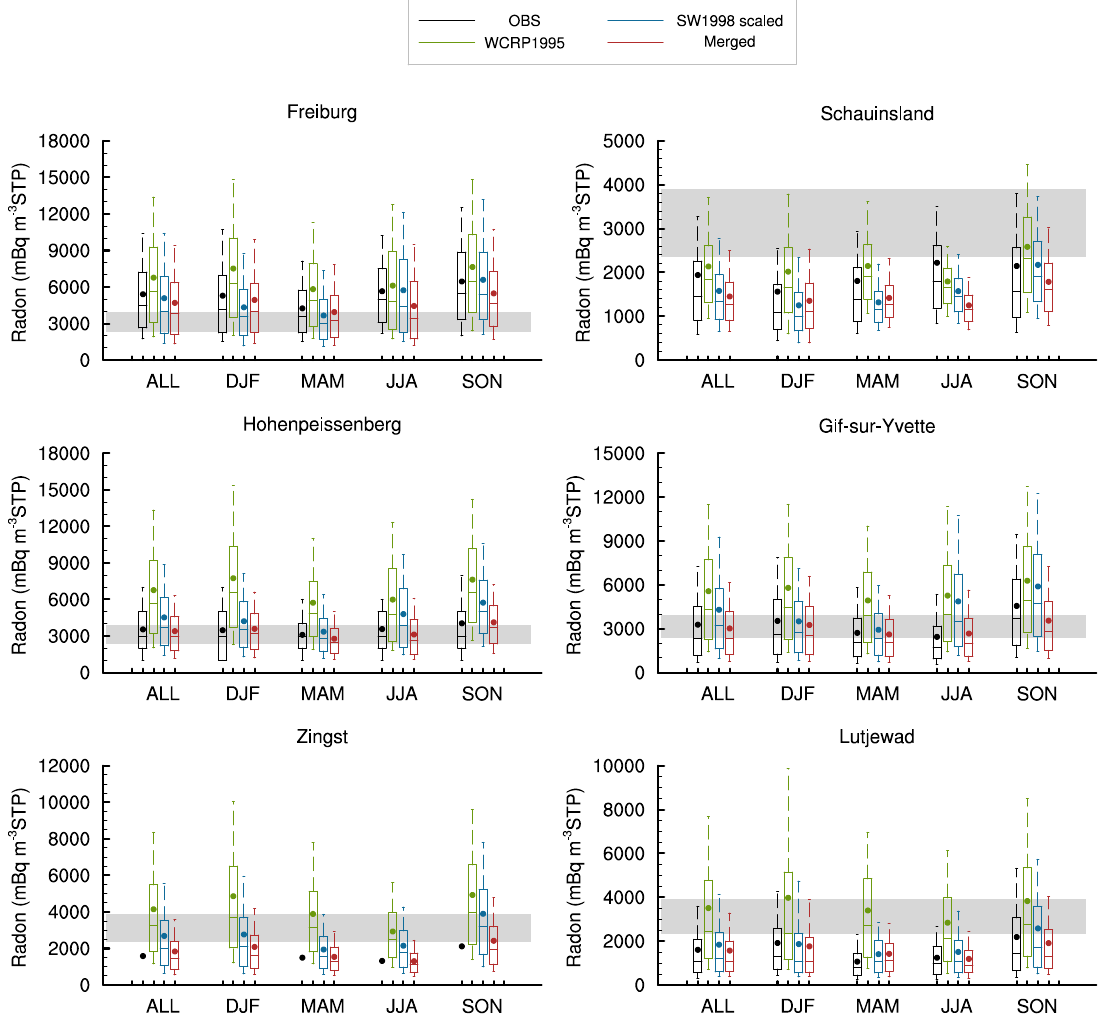
Fig. 7. Box plots showing the simulated and observed distribution of surface radon concentration at six sites in Europe. The two whiskers of each box denote the 10th (lower) and 90th (upper) percentiles. Hinges from bottom to top are the 25th, 50th, and 75th percentiles, respectively. Seasonal and annual means are indicated by dots. The gray areas indicate magnitude of the equivalent radon concentration that would lead to the same ionization rate as caused by galactic cosmic rays. The lower and upper boundaries of the gray areas correspond to the 10th and 90th percentiles, respectively. See paragraph 3 of Sect. 3.4 for further details.